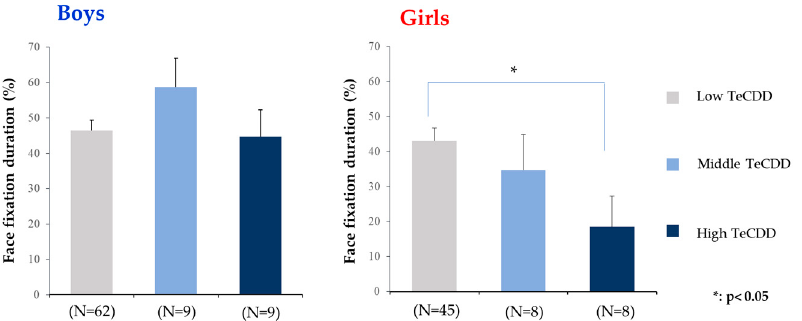
Figure 2. The dose–effect relationship between perinatal TCDD exposure and gaze performance: